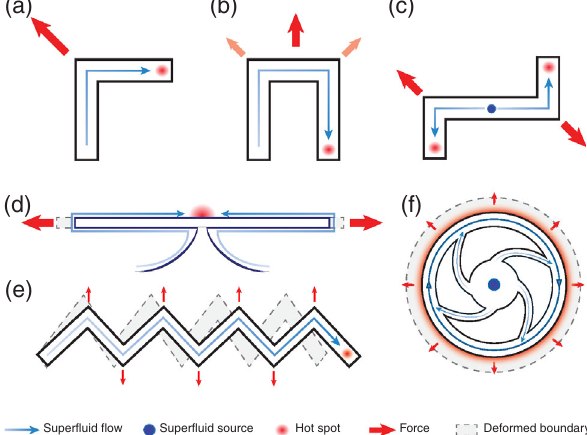
FIG. 6. By varying the geometry, superfluid flow could be used to apply a large range of different forces including (a), (b) linear force, (c) torque, (d) – (f) examples of geometries designed to efficiently leverage forces from superfluid flow. (d) Expansive force that is efficiently coupled to a microdisk or microtoroid, (e) compressive force, and (f) long-lived centrifugal forces resulting from persistent current